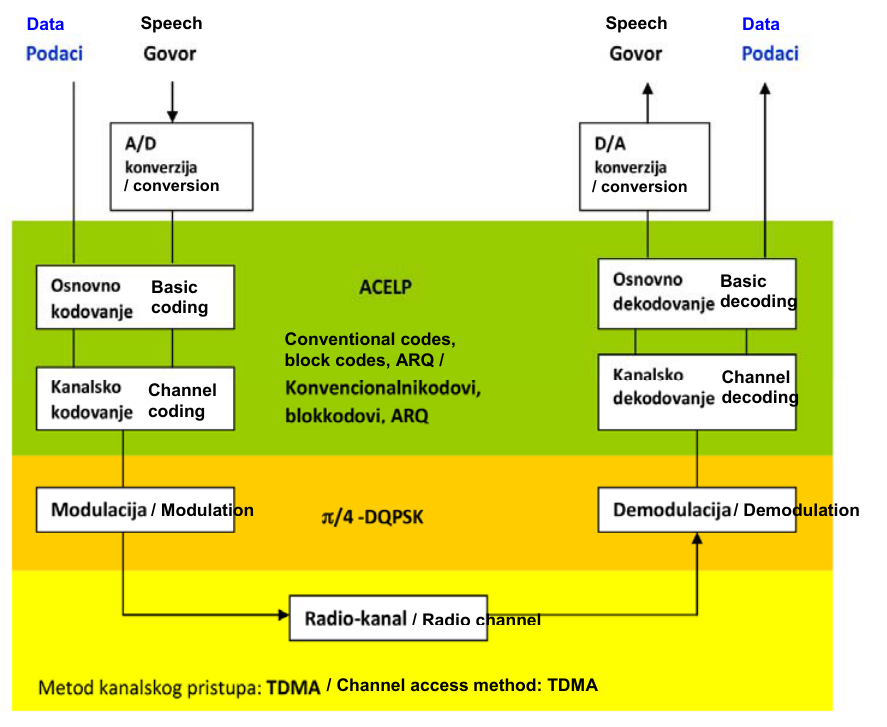
Figure 7 – Overview of the integration of speech and data transmission and signal processing in the TETRA 1 standard (Svrzi ć & Ć osovi ć ,